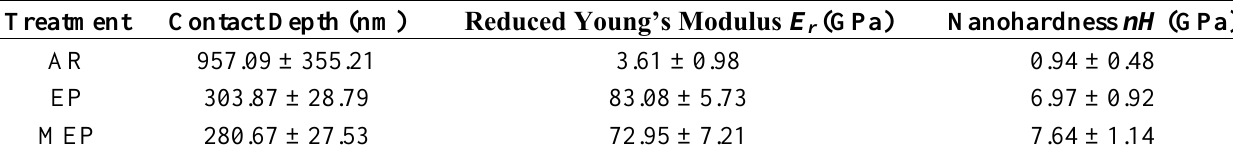
Figure 1. Optical microscope results of TNZ alloy sample surface: AR, as received ( a ); EP, after electropolishing ( b ); MEP, after magnetoelectropolishing ( c ). (window: 548 µm × 470 µm). Table 1. Nanoindentation measurement results of TNZ alloy sample surfaces.